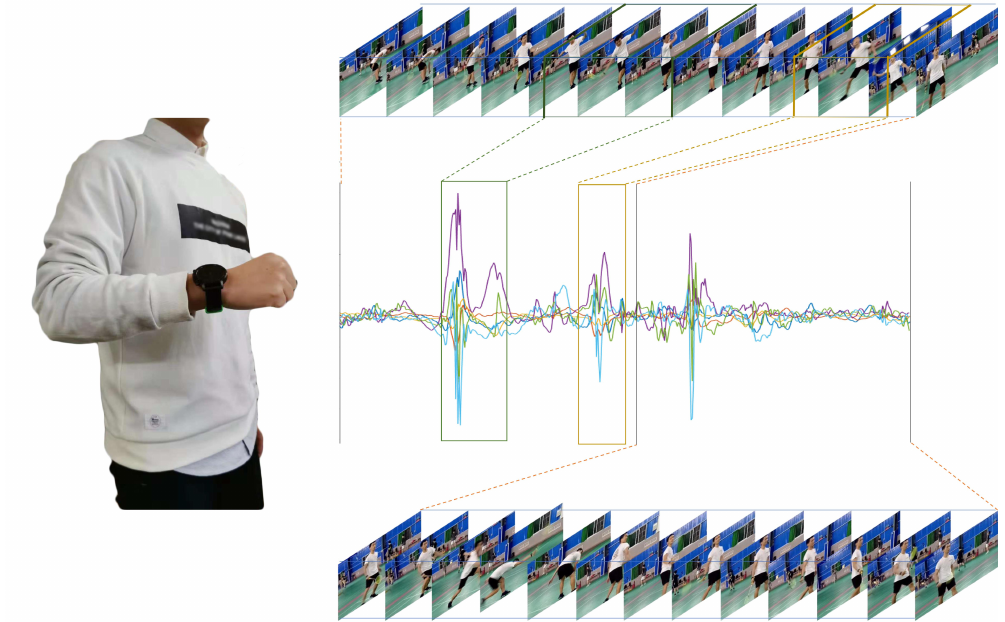
Figure 2. The graph shows the correct way to wear the watch, as well as the form of the data used in this paper. The left side shows the proper way to wear the watch. The middle of the right side shows the waveform of sensor signals collected by the watch during badminton. On the top and bottom of the waveforms are real-time pictures of the wearer’s movements. In particular, the waveform in the green box corresponds to the serving movement, the waveform in the yellow box corresponds to the swinging movement, and the frames corresponding to these two motions are framed by the corresponding dotted colored